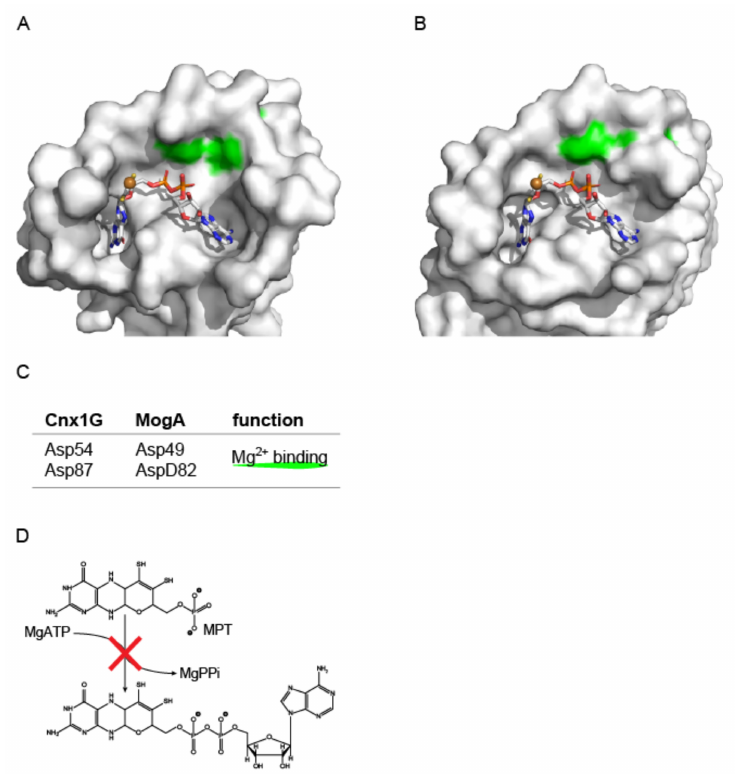
Figure 7. Understanding G-domain functionality: Site by site comparison of MogA and Cnx1G. Active site view of Cnx1G variant S583A ( A , PDB entry: 1UUY, [22] and MogA ( B , PDB entry: 1DI6, [41]. The molecular surface is shown, residues that were identified to be important for catalysis [41], see ( C ) are highlighted. MPT-AMP is shown in stick notation. The MPT-AMP molecule shown in ( B ) has been placed into the active site based upon a superimposition of the Cnx1 G-domain S583A variant (PDB entry: 1UUY, [22]) and MogA (PDB entry: 1DI6, [41]). Atoms are colored as follows: carbon, grey; oxygen, red; nitrogen, blue; phosphorous, orange; sulfur, yellow; cupper brown. Hydrogen atoms are omitted. ( C ) Catalytically relevant residues identified MogA [41] and their homologous Cnx1 G-domain residues are tabulated. ( D ) The Mo-insertase G-domain catalyzes the adenylylation and B were created with PyMOL